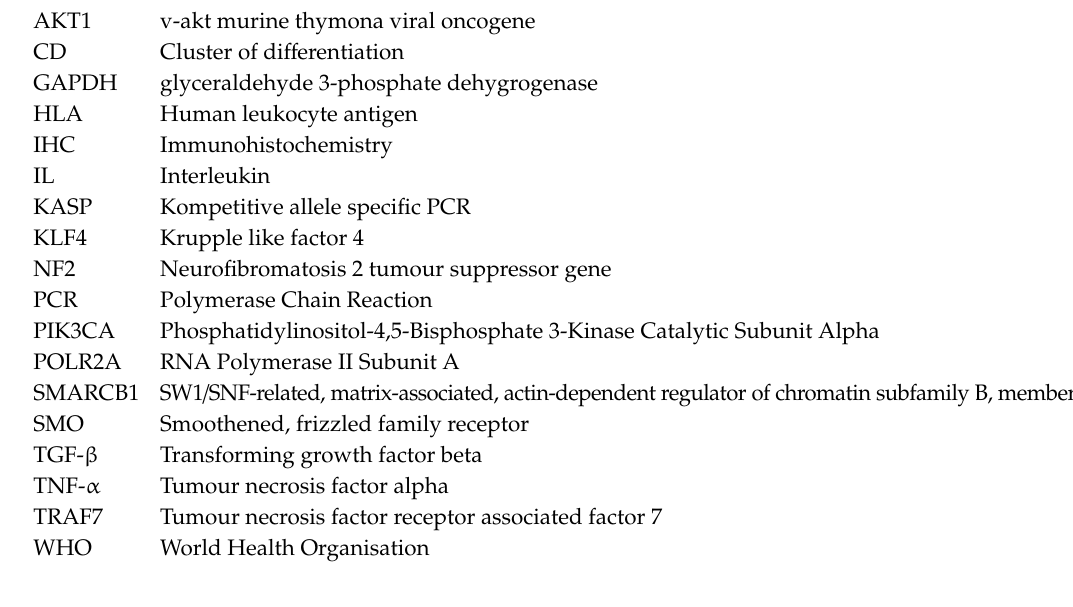
Figure S1—Flow cytometry gating strategy, Table S1—Genotyped samples, Table S2—Macrophage data, Table S3—Olignonucleotide details, Table S4—Antibody